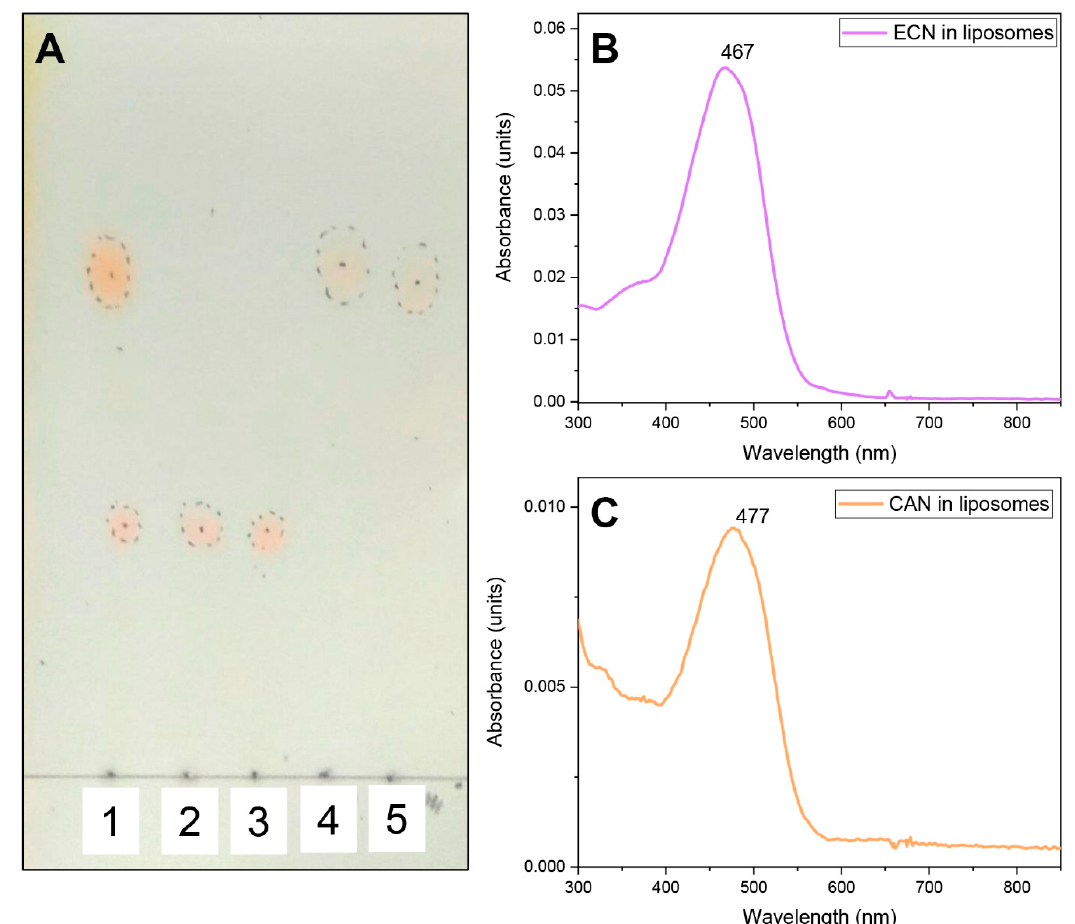
Figure A2. Analysis of ECN and CAN by thin layer chromatography and absorbance spectroscopy. ( A ) thin layer chromatogram in a 80:20 kerosene:acetone ( v / v ) system showing the carotenoid content in the membranes of the ECN/CAN-producing E. coli strain [29,34] (1) and the samples containing AnaCTDH(CAN) (2), CAN-loaded liposomes (3), AnaCTDH(ECN) (4), or ECN-loaded liposomes (5) used in the study. ( B ) absorbance spectrum of ECN in liposomes obtained by running SEC with full absorbance spectrum detection. The spectrum was corrected for the high scattering from liposomes by subtracting the scattering profile measured on empty liposomes. ( C ) Absorbance spectrum of CAN in liposomes obtained by running SEC with full absorbance spectrum detection. The spectrum was corrected for the high scattering from liposomes by subtracting the scattering profile measured on empty liposomes. Note the difference of the peak maximum position for ECN and CAN.